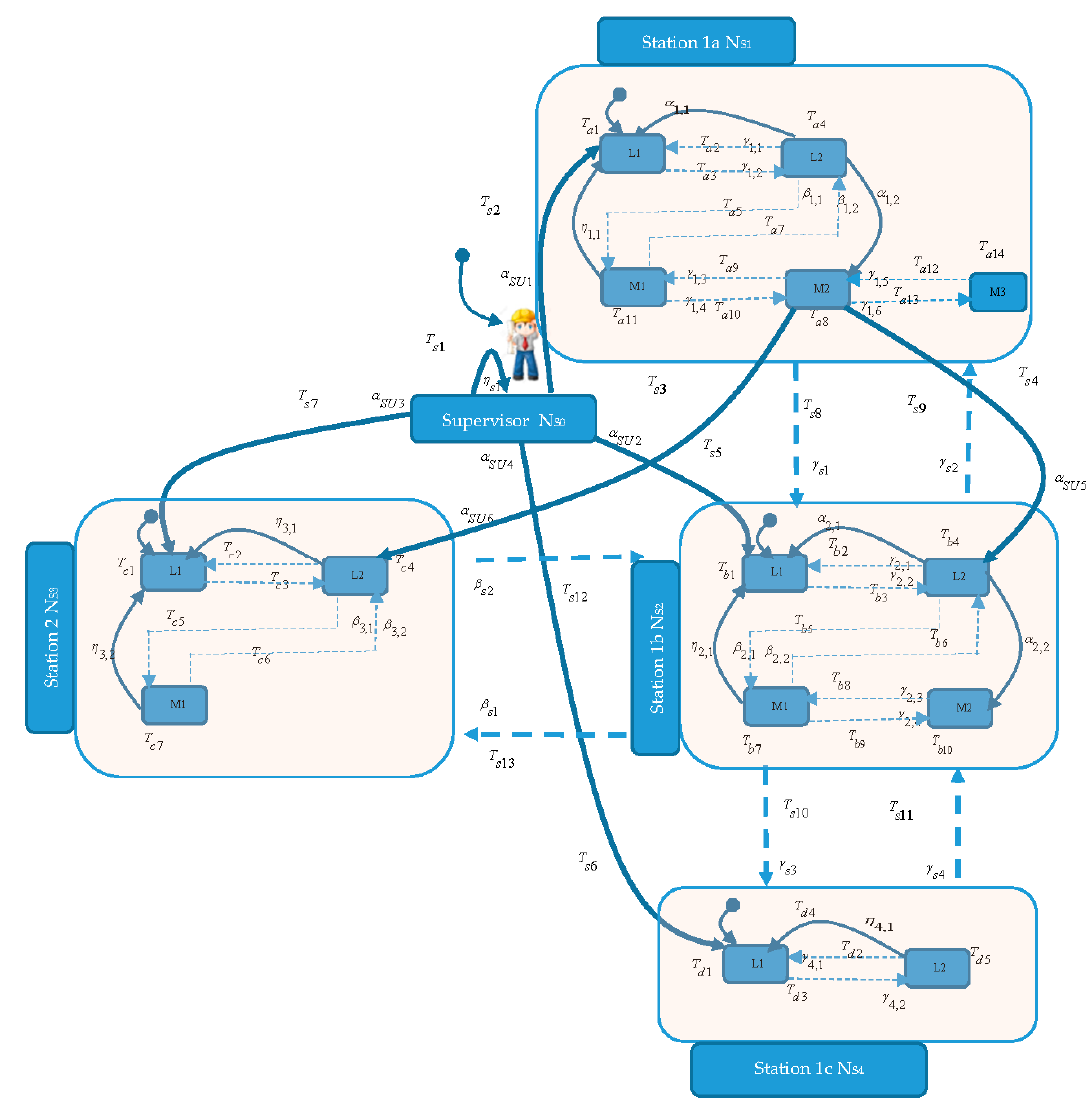
Figure 3. An example of supervisor interface model.